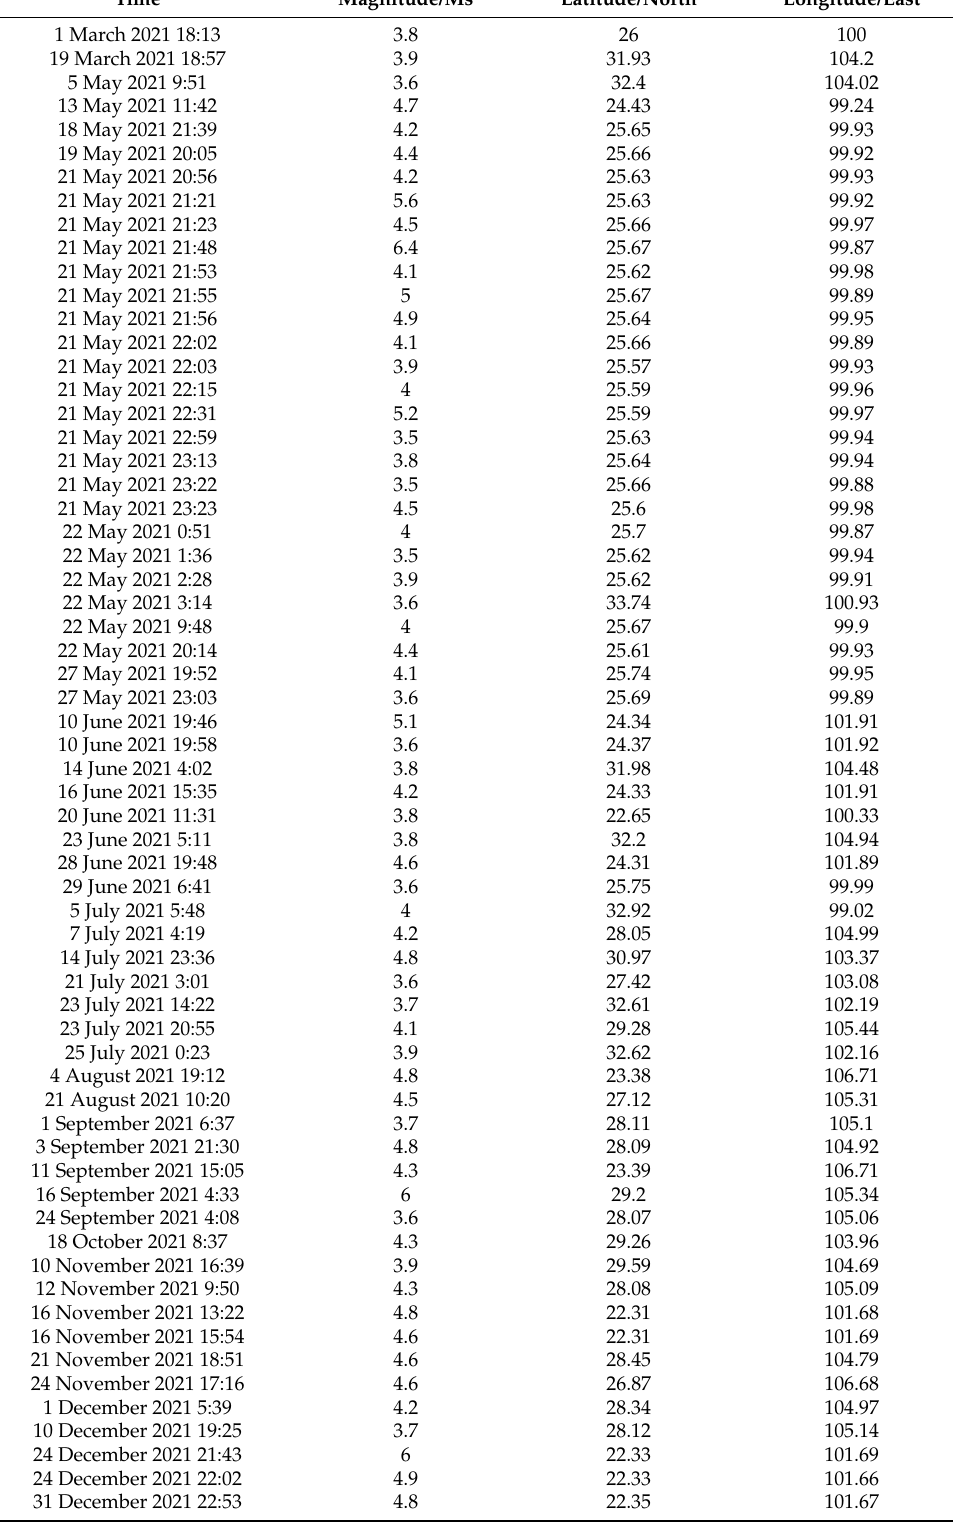
Table 2. Table shows earthquakes used to evaluate the